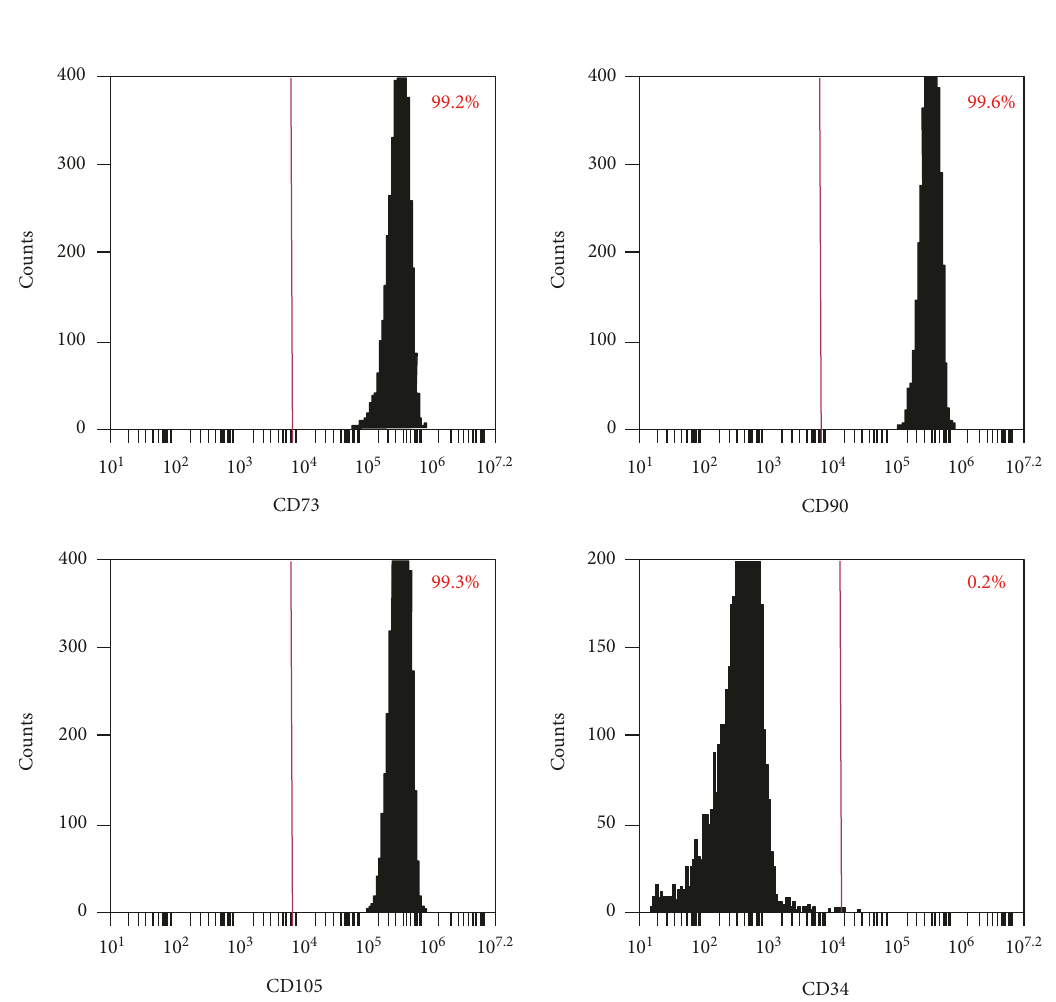
Figure 1: DPCs phenotype via fl ow cytometry. The expression of a series of cell surface markers associated with the mesenchymal stem cell (MSC) phenotype was investigated using fl ow cytometry. Analysis of molecular surface antigen markers in DPCs by fl ow cytometry indicated that the cells were negative for CD34, whereas they were positive for CD73, CD90, and